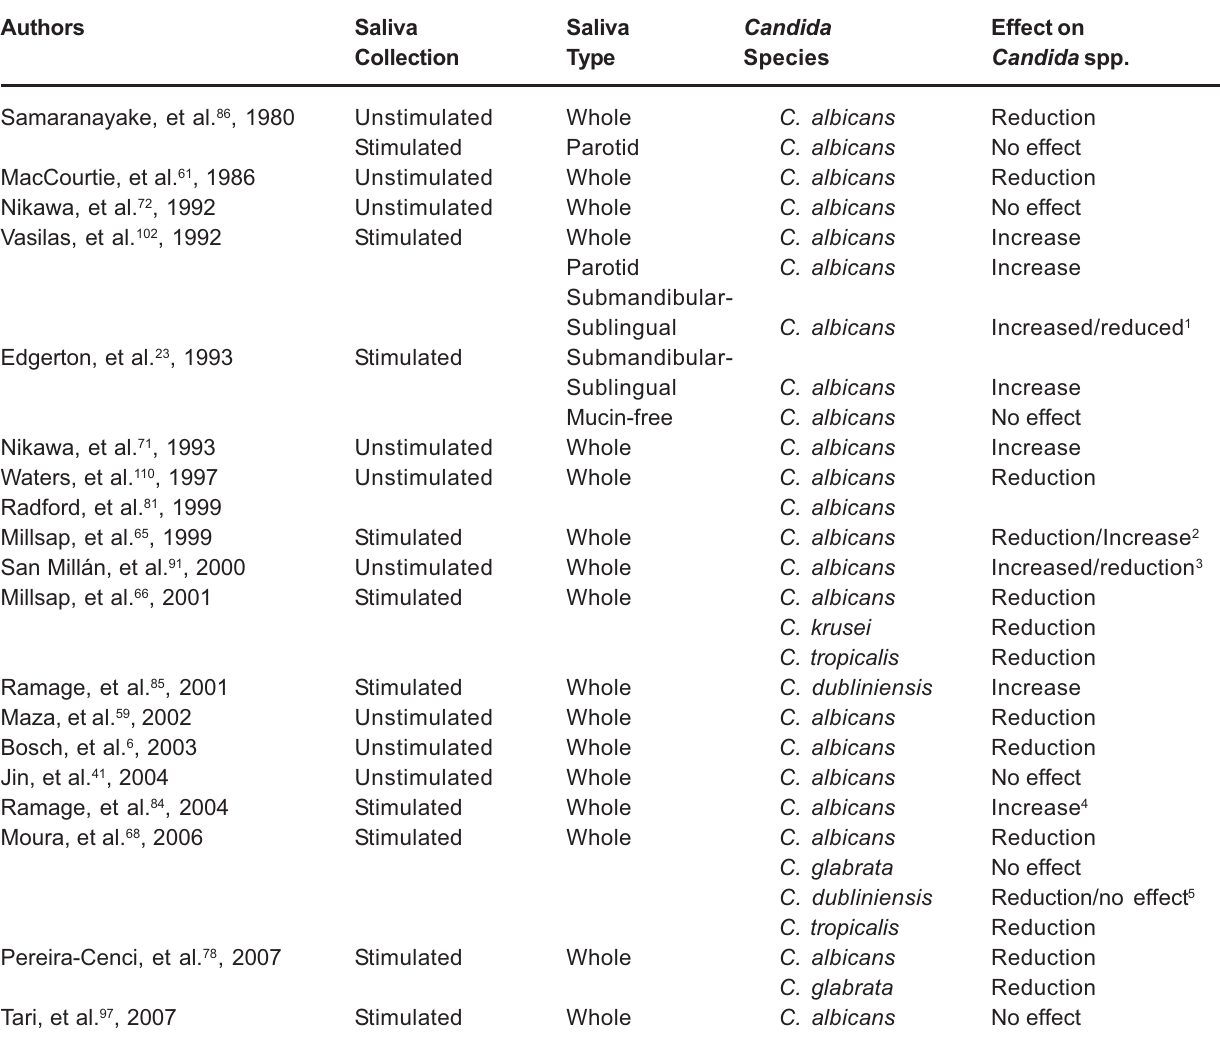
TABLE 1- The effect of saliva on Candida species adherence/biofilm formation on acrylic surfaces, according to published